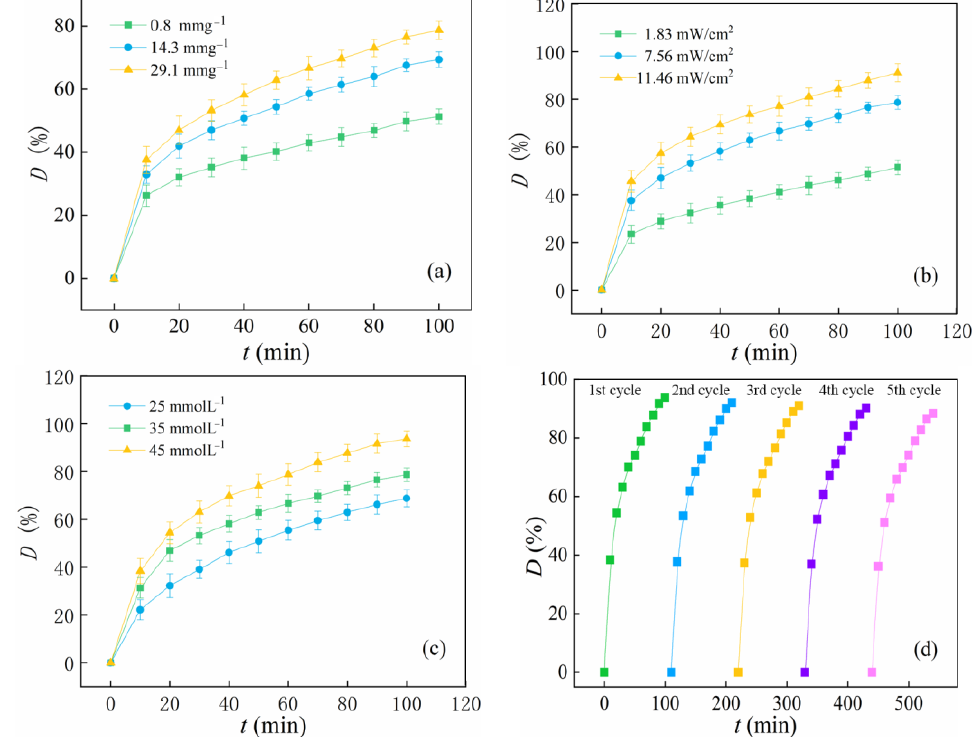
Figure 11. Photocatalytic performance of 0.1 g n-hemin/PAN (under H 2 O 2 /visible light) in different conditions: ( a ) hemin loading amount, ( b ) irradiation intensity, ( c ) H 2 O 2 concentration, ( d ) recycling ability.